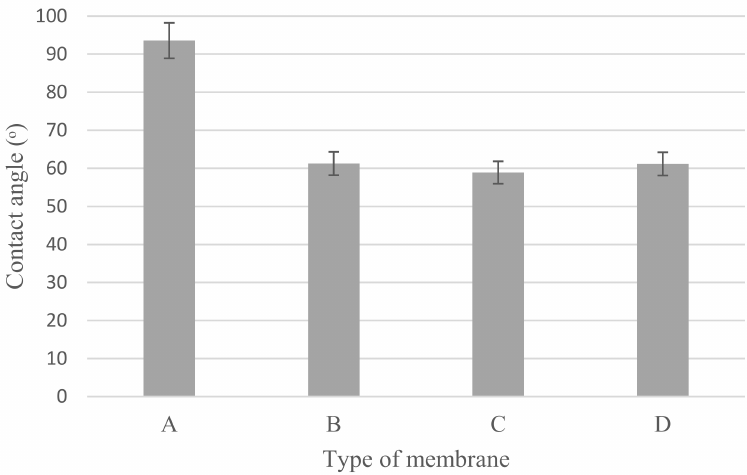
Figure 7. Contact angle of (A) neat PVDF membrane, (B) 0.25 Cu 2 O/PVDF DLHF membranes, (C) 0.5 Cu 2 O/PVDF DLHF membranes and (D) 0.75 Cu 2 O/PVDF DLHF membranes with outer dope flowrate 6